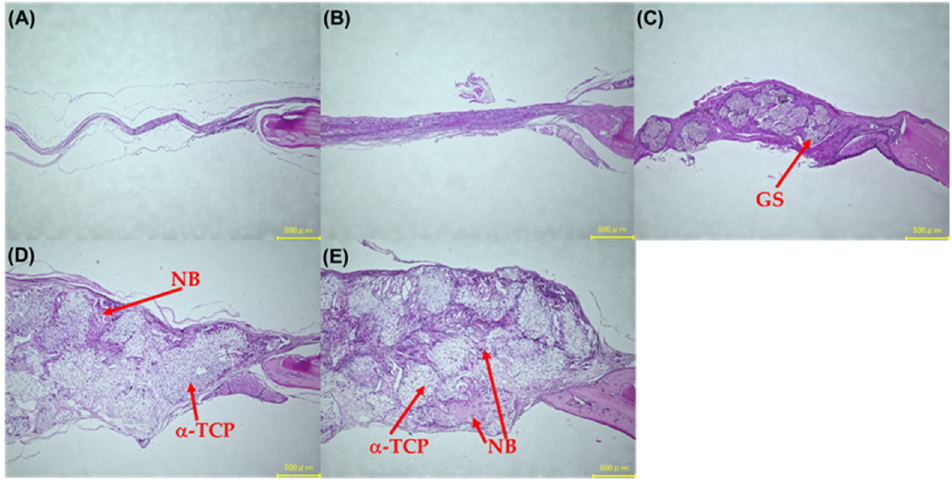
Figure 15. HE stained tissue specimen ( A ) defect group, ( B ) GS group, ( C ) GS + DFAT group, ( D ) α -TCP/GS group, and ( E ) α -TCP/GS + DFAT group. α -TCP/GS, composite gelatin sponge; GS, gelatin scaffolds; and DFAT, dedifferentiated fat cell. Scale bar indicates 500 μ m. NB: new bone; GS: gelatin sponge.